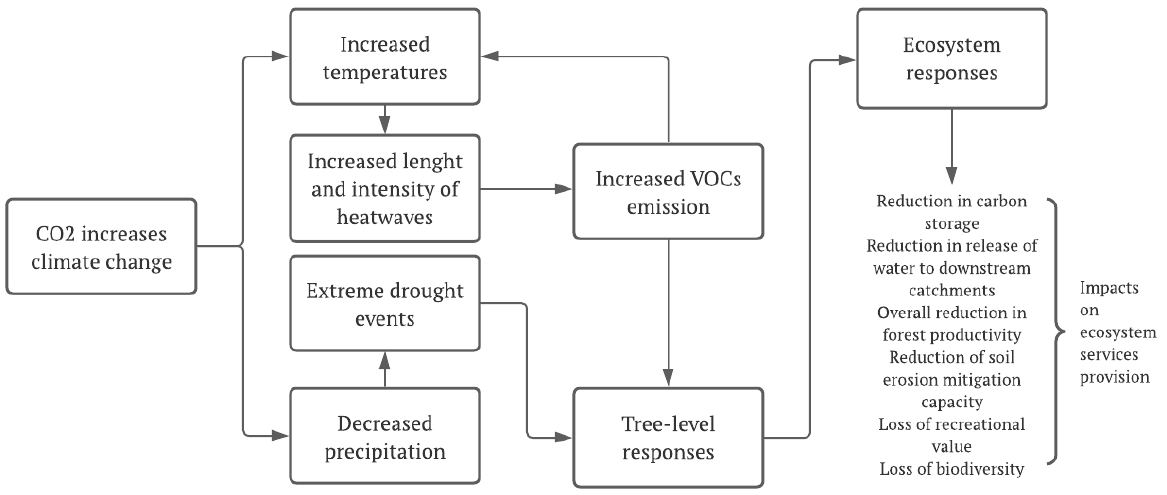
Figure 3. Tree- and ecosystem-level responses in Mediterranean forests to environmental changes associated with climate change and their impacts on ecosystem service (ES) provision [27] .